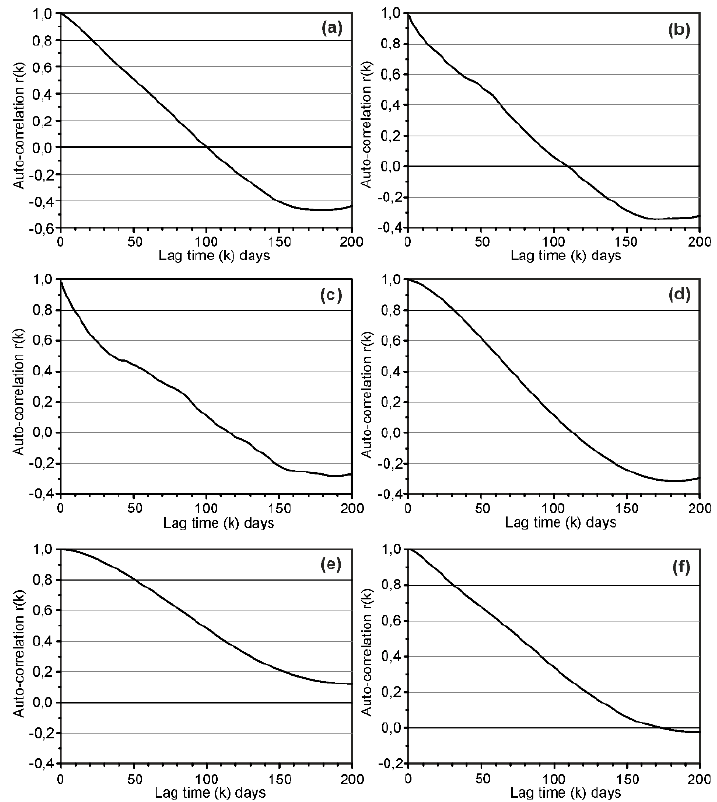
Figure 6. Auto-correlation functions of the analyzed aquifer springs; ( a ) Scirca spring, ( b ) Vaccara spring, ( c ) Boschetto spring, ( d ) Capo d’Acqua spring, ( e ) San Giovenale spring, and ( f ) Bagnara spring.